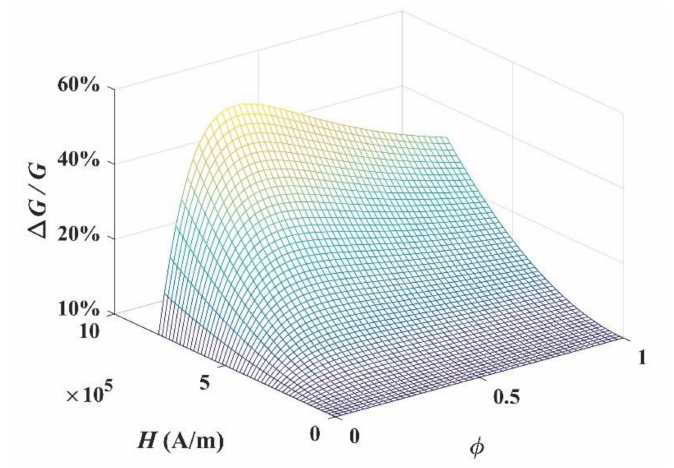
Figure 3. Effect of volume ratio of Fe particles and magnetic field on shear modulus of magnetorheological elastomers (MREs).